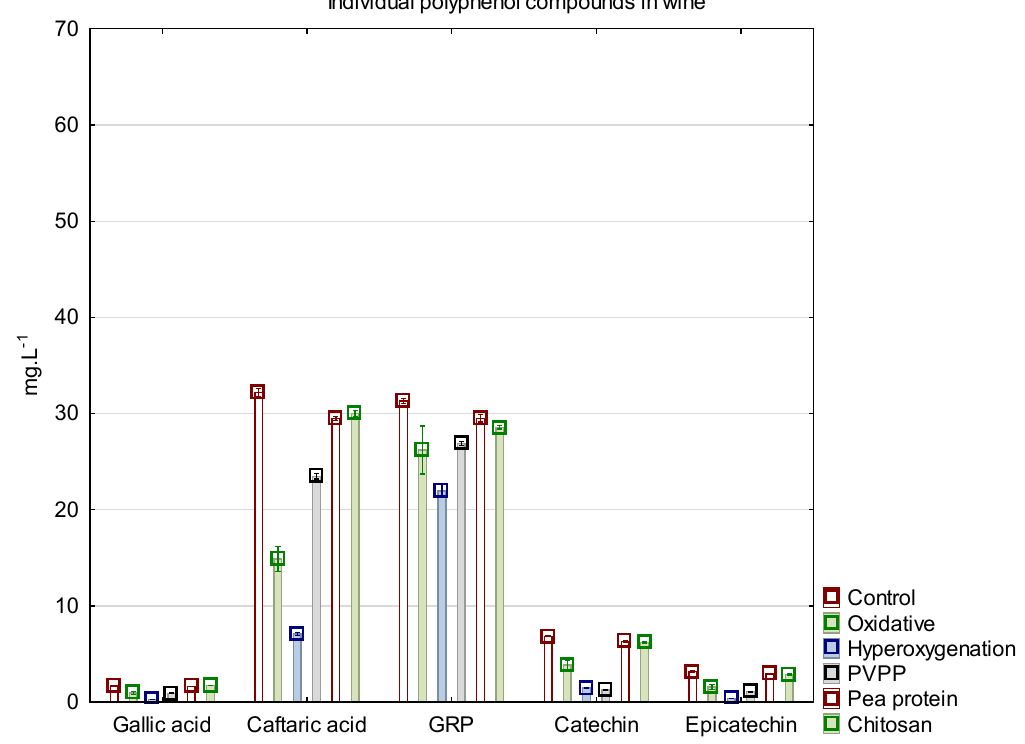
Figure 4. Comparison of selected phenolic compounds in order to individual variants in wine. The average values ( n = 3) were combined by contribution into homogeneous groups according to Fisher ´ s Least significant difference (LSD) test, where different letters in the same row indicate significant differences between individual variants ( α = 0.05) (Table